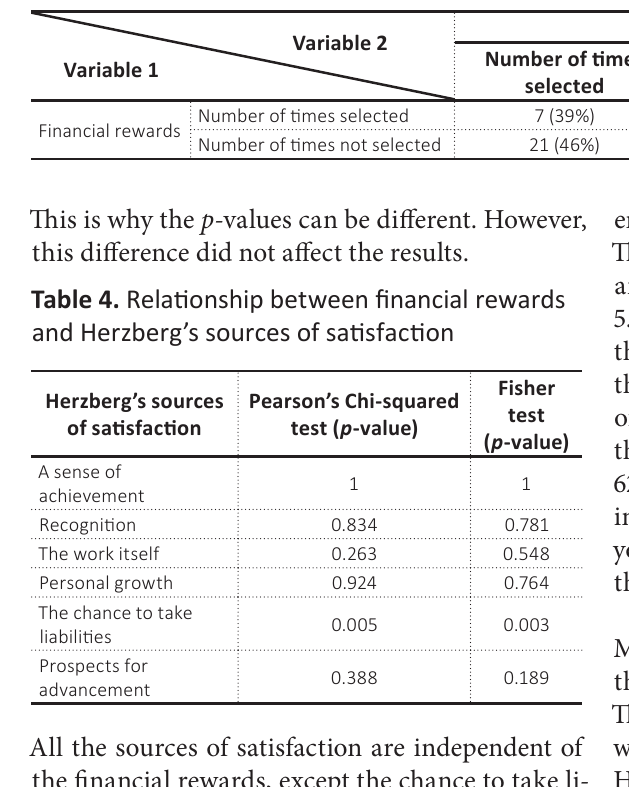
Table 3. Contingency table for financial rewards and